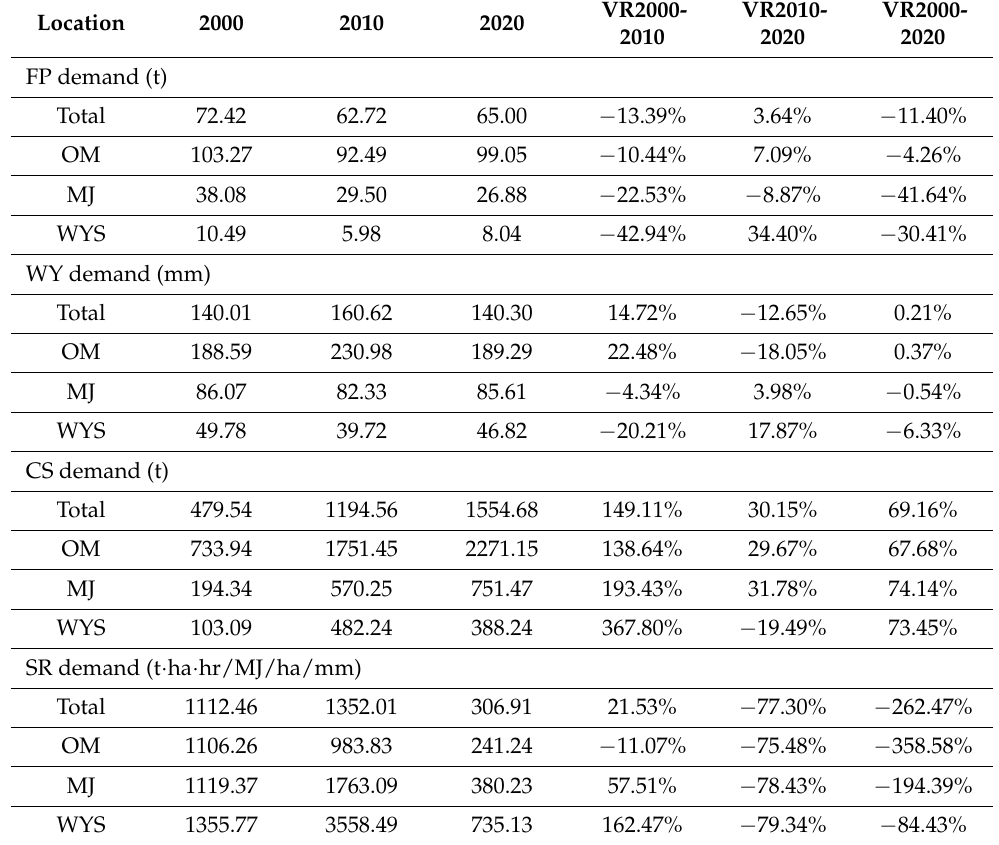
Table 5. The ecosystem services’ demand mean values in different areas and their variation rate. Location